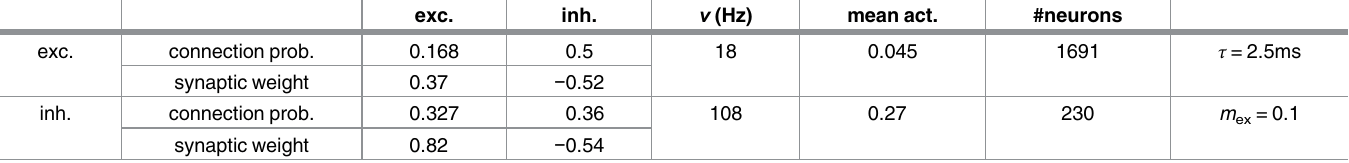
Table 1. Parameters for the biologically inspired network model used in Figs 5 and 6 and Figs A, B, C and D in S1 Text. exc. inh. ν (Hz) mean act. exc. connection prob. synaptic weight − 0.52 inh. connection